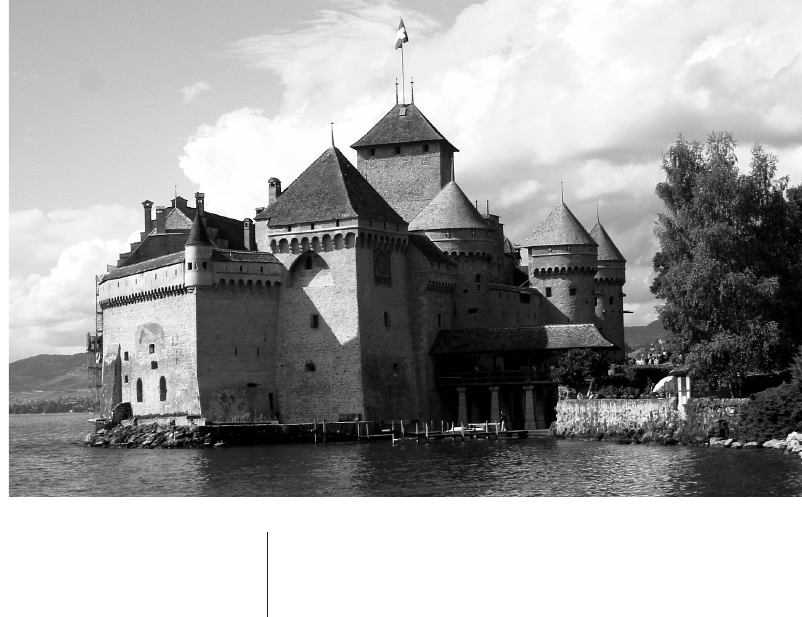
Figure 3 (below): Tuesday excursion to Chillon Castle on the shore of Lake